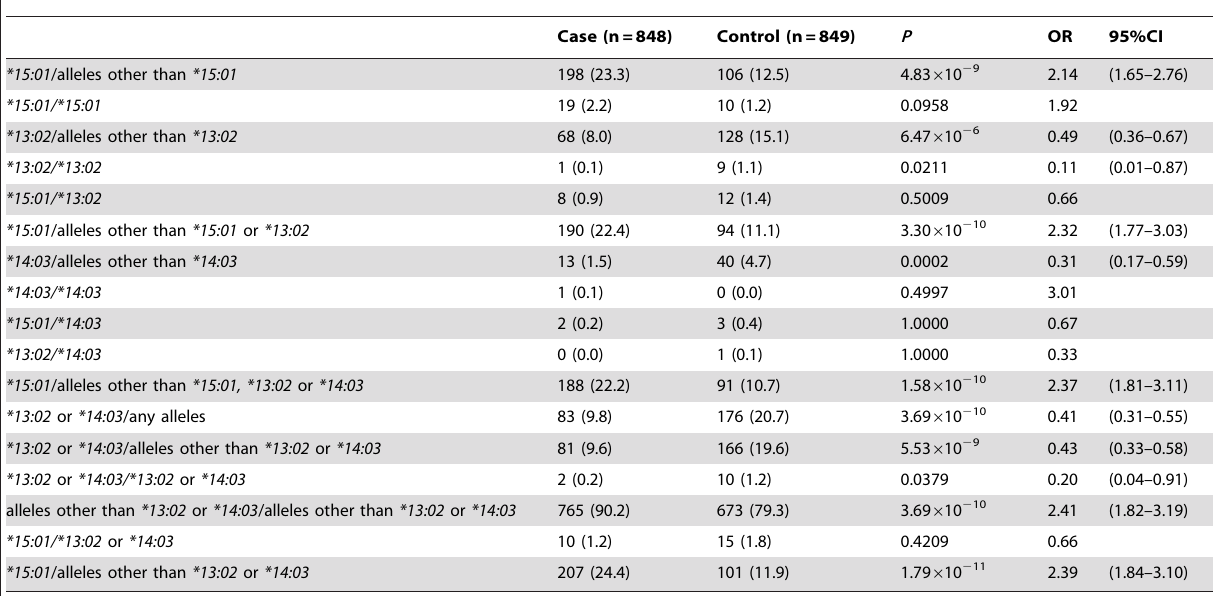
Table 2. HLA-DRB1 genotype frequency in the SLE patients and controls.